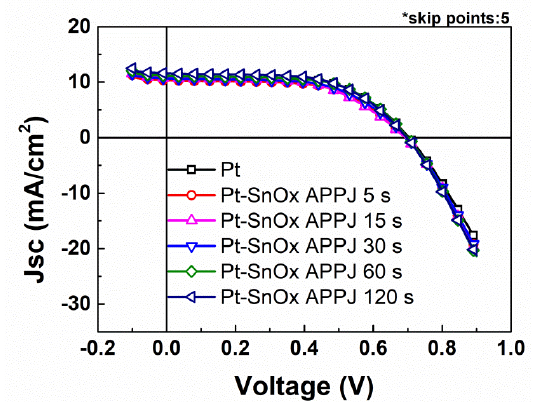
8 of 13 Figure 6. Tafel curves of symmetric cells with various Pt-SnO x CEs. Figure 7 shows the IV curves of DSSCs with APPJ-processed Pt-SnO x CEs. Table 4 shows the photovoltaic parameters, including the open-circuit voltage ( V oc ), short-circuit current ( J sc ), fill factor (FF), and efficiency (EFF) with their standard deviations. The power conversion efficiencies (PCEs) of DSSCs with 5 s and 15 s APPJ-processed Pt-SnO x CEs are 3.87 ± 0.58% and 3.86 ± 0.28%, respectively, indicating that APPJ processing for a short duration can improve the DSSC performance. XPS results show that almost no metallic Pt was converted with 5 s and 15 s APPJ